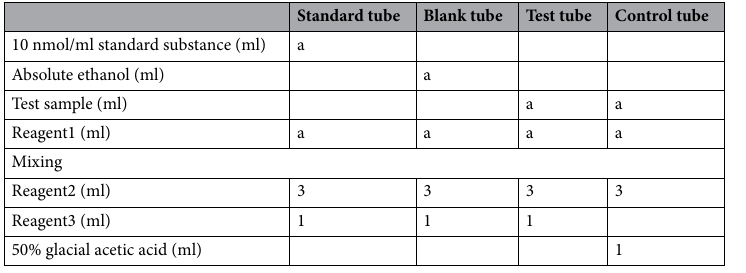
Table1. The MDA reaction